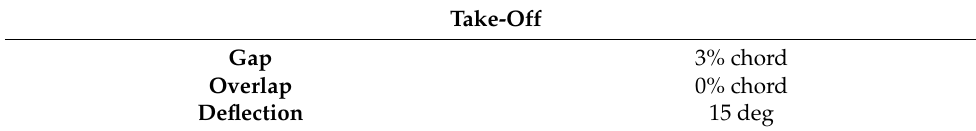
Table 11. Flap position take-off.